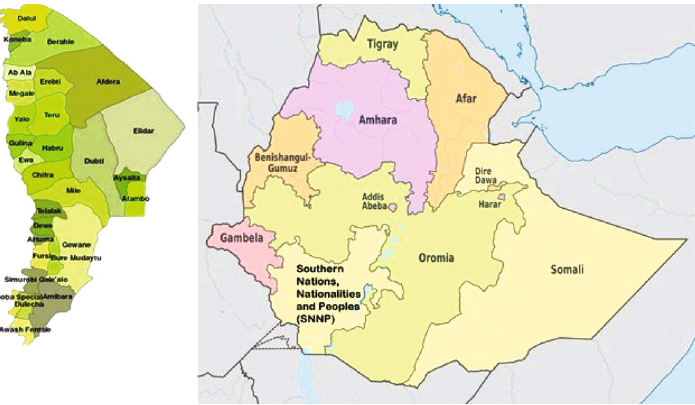
Figure 2: Map of Afar region,